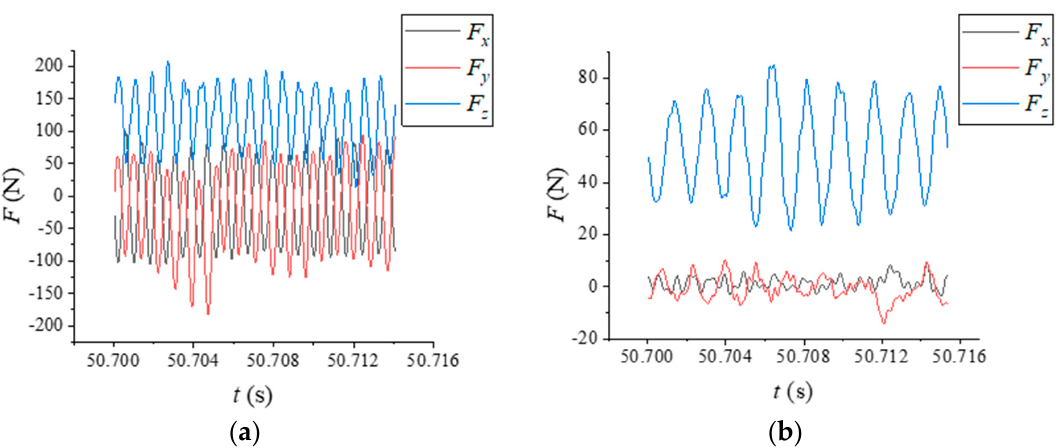
Figure 18. Cutting force of ordinary and step-cutter (Position 1, n = 1000 r/min, a p = 0.2 mm). ( a ) Ordinary helical milling cutter. ( b ) Step-cutter.